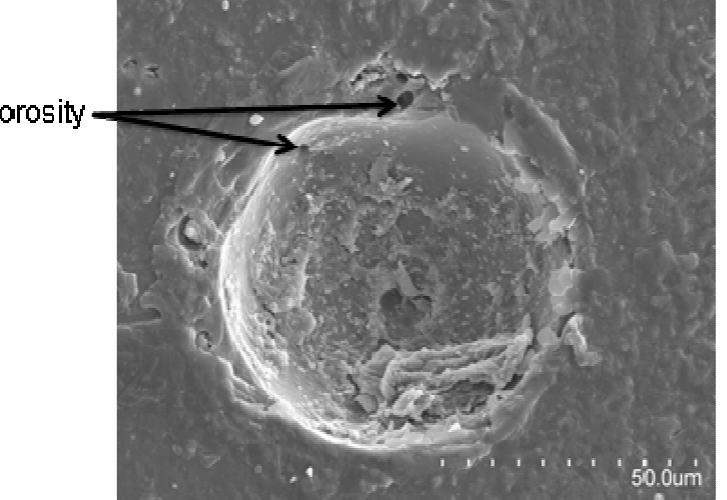
Figure 7. Scanning electron micrograph of AZ91D/fly ash cenosphere composite, where porosity and defects are visible in the cenosphere